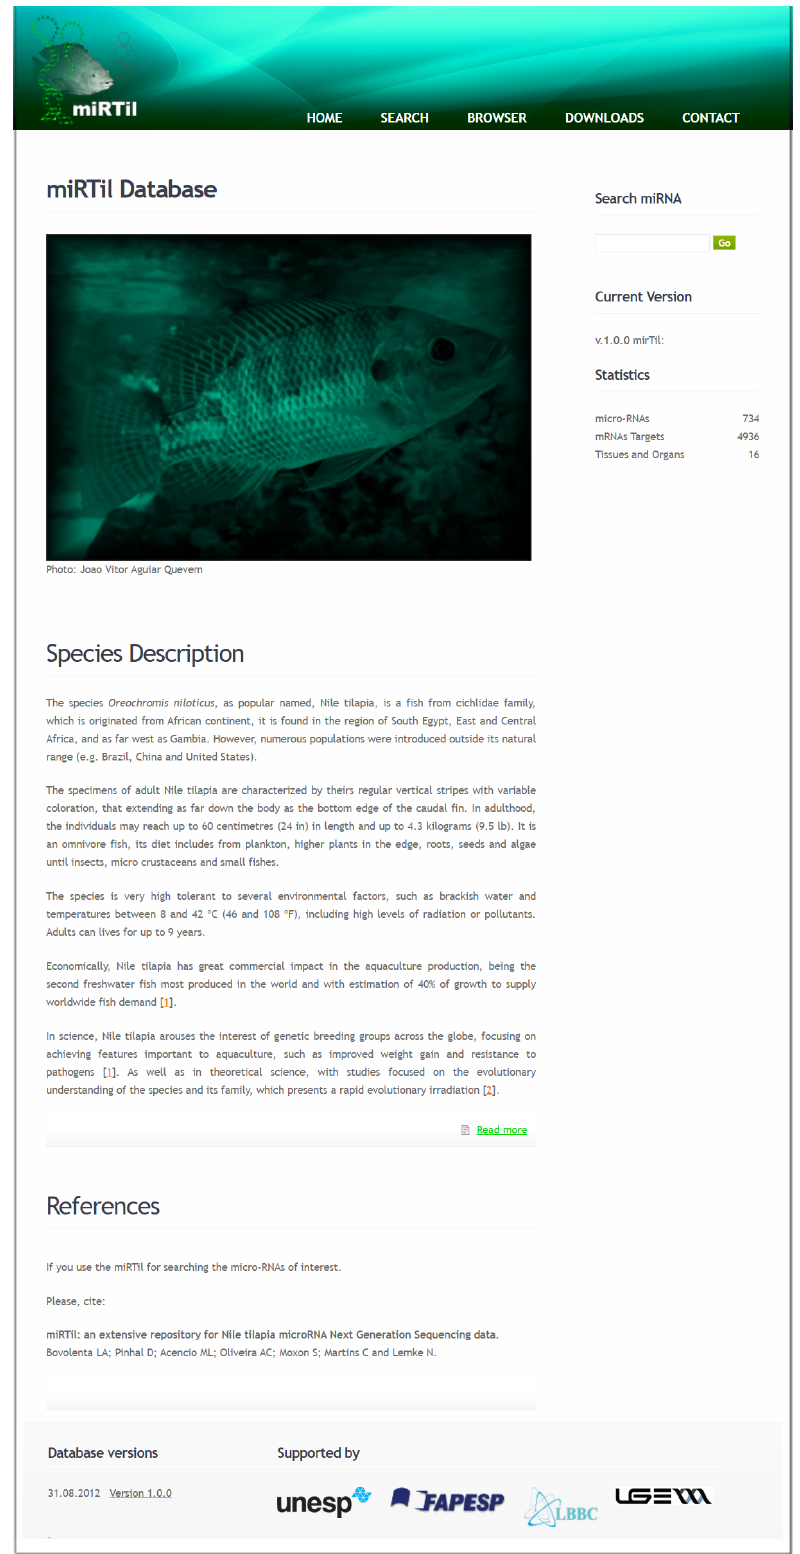
Figure 3. MiRTil database. The home page contains a brief description of Nile tilapia and microRNA (miRNA) data statistics, as well as the ability of a quick search of miRNA data, links to developmental and support groups, old versions of the database, and menu of